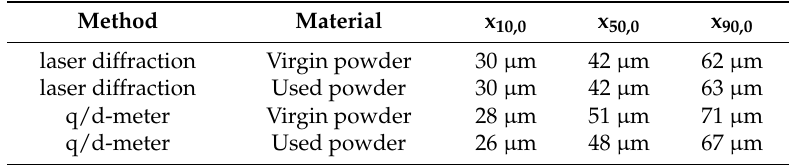
Table 3. Characteristic particle sizes of PA12 laser sintering powders for different ageing states and measurement